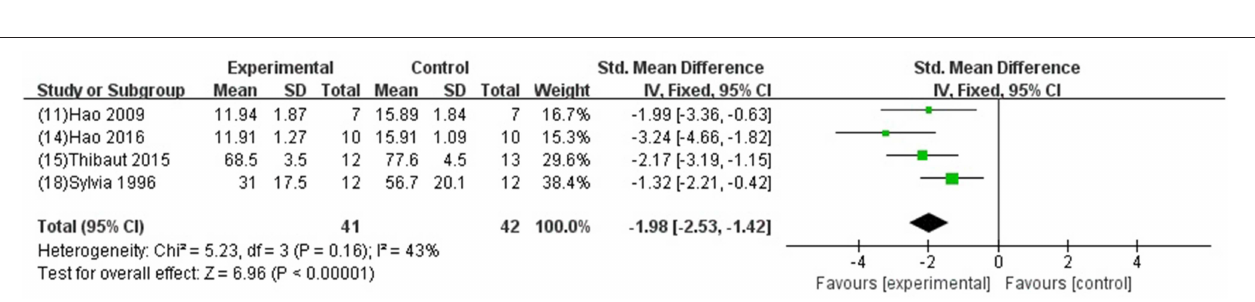
FIGURE 6 | Forest plot of animal studies investigating the effect of GB on LVEDP